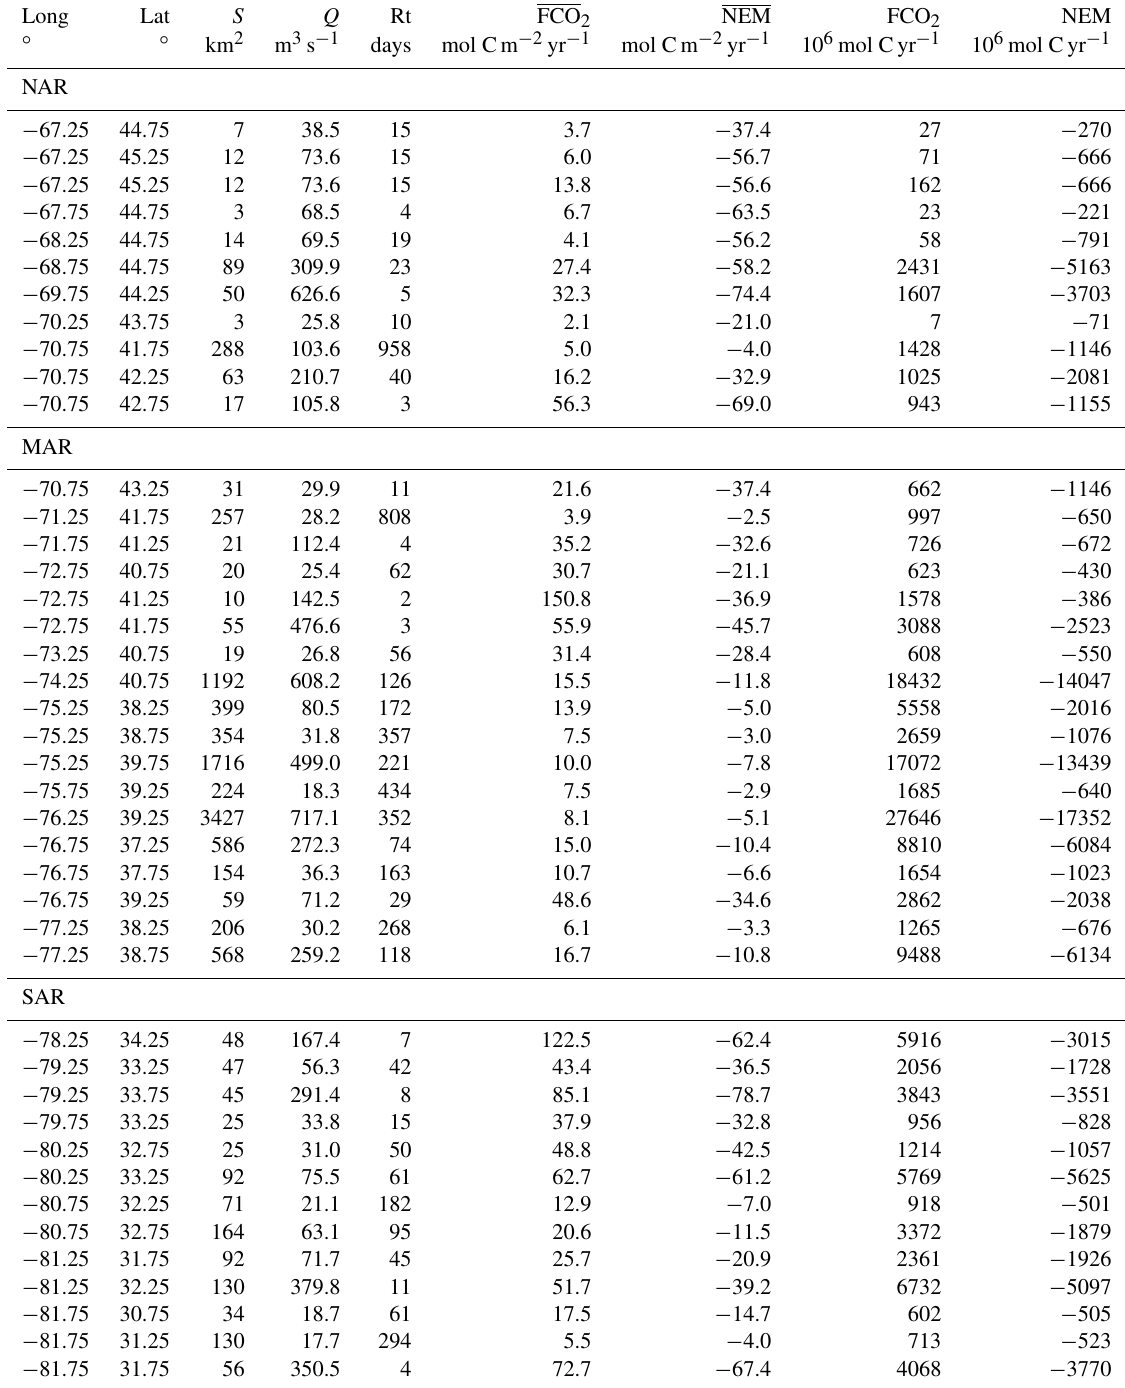
Table 4. Yearly averaged surface area ( S) , freshwater discharge ( Q) , residence time (Rt), FCO 2 , and NEM of all simulated